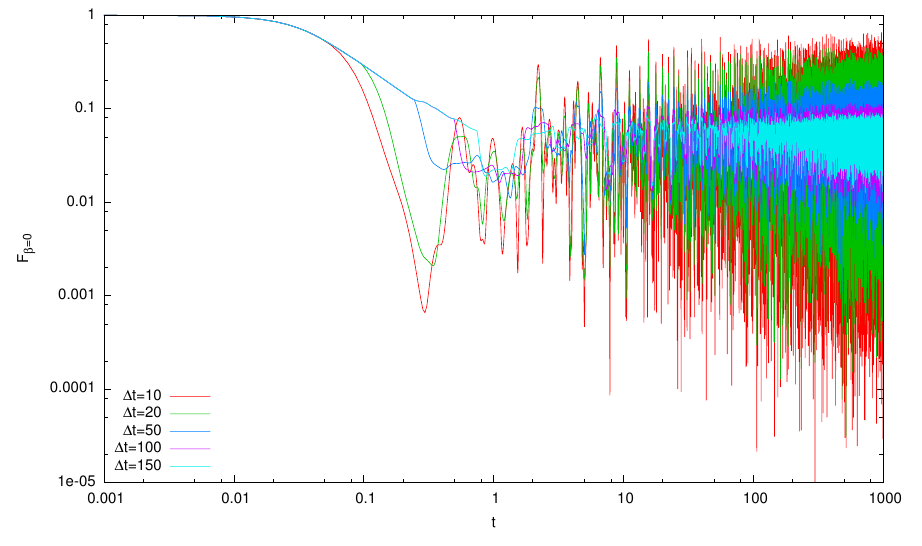
Figure 4 . SFF for (cid:12) = 0 for various window sizes ((cid:1) t ). Similar to SYK and Gurau-Witten models, there is a dip-ramp-plateau structure present here as well, suggesting a random matrix/chaotic behaviour.